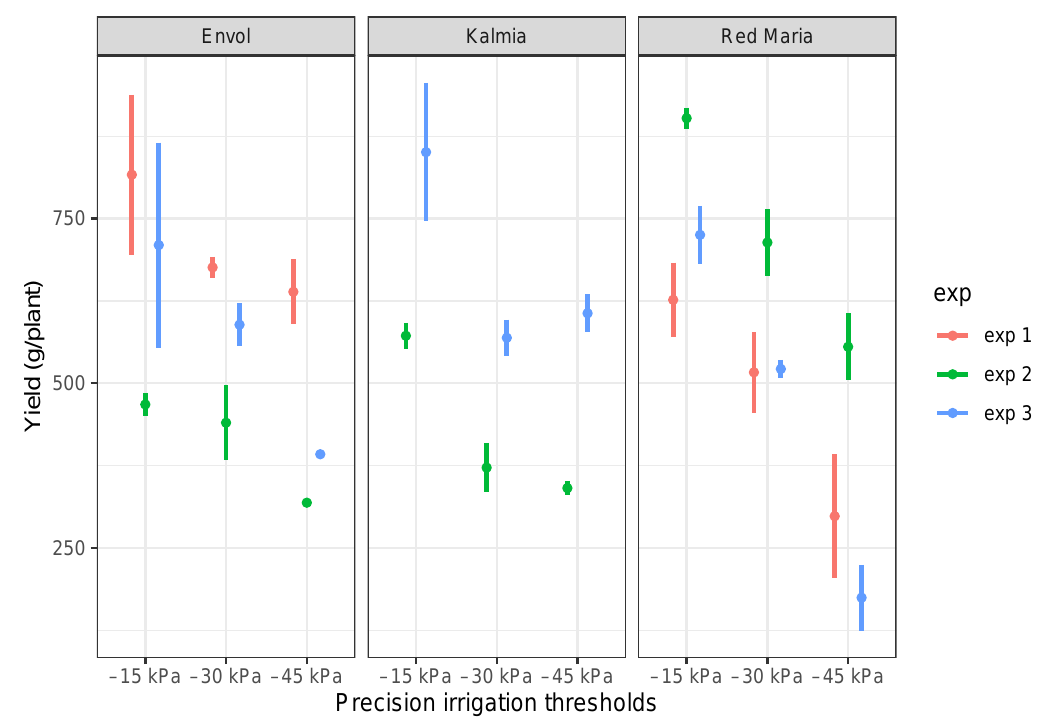
Figure 3. Distribution of the total tuber yield of each variety, experiment and precision irrigation thresholds. Error bars show the standard error of the total yields. The colors show the experiments for each variety.